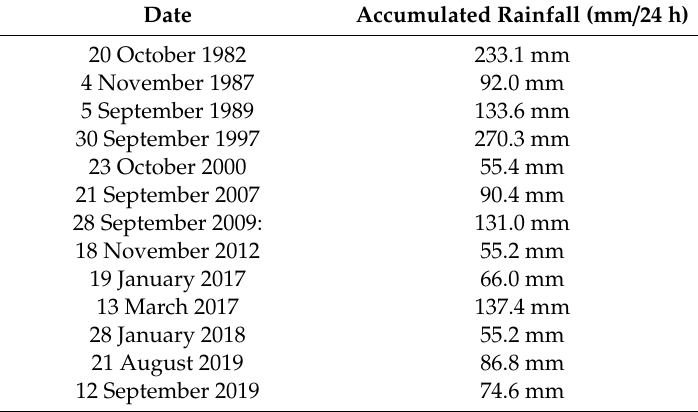
Table 1. Episodes of intense rainfall ( > 50 mm / 24 h) with flooding e ff ects in the city of Alicante